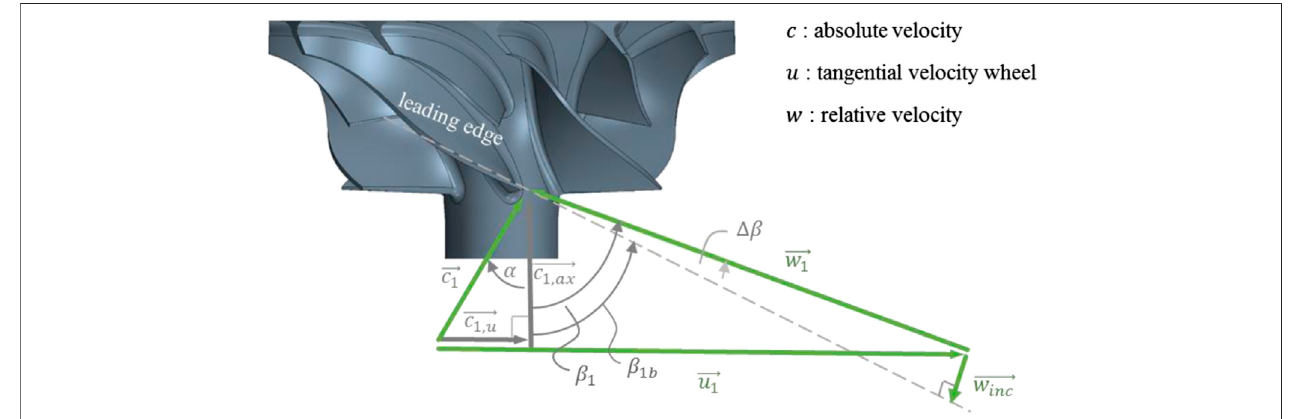
FIGURE 1 | Velocity triangle at the compressor